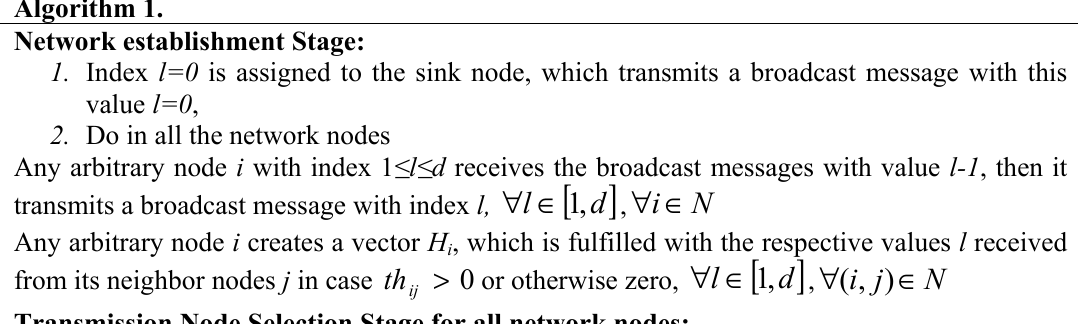
Table 2. Algorithm 1: LOAM pseudo code. Algorithm